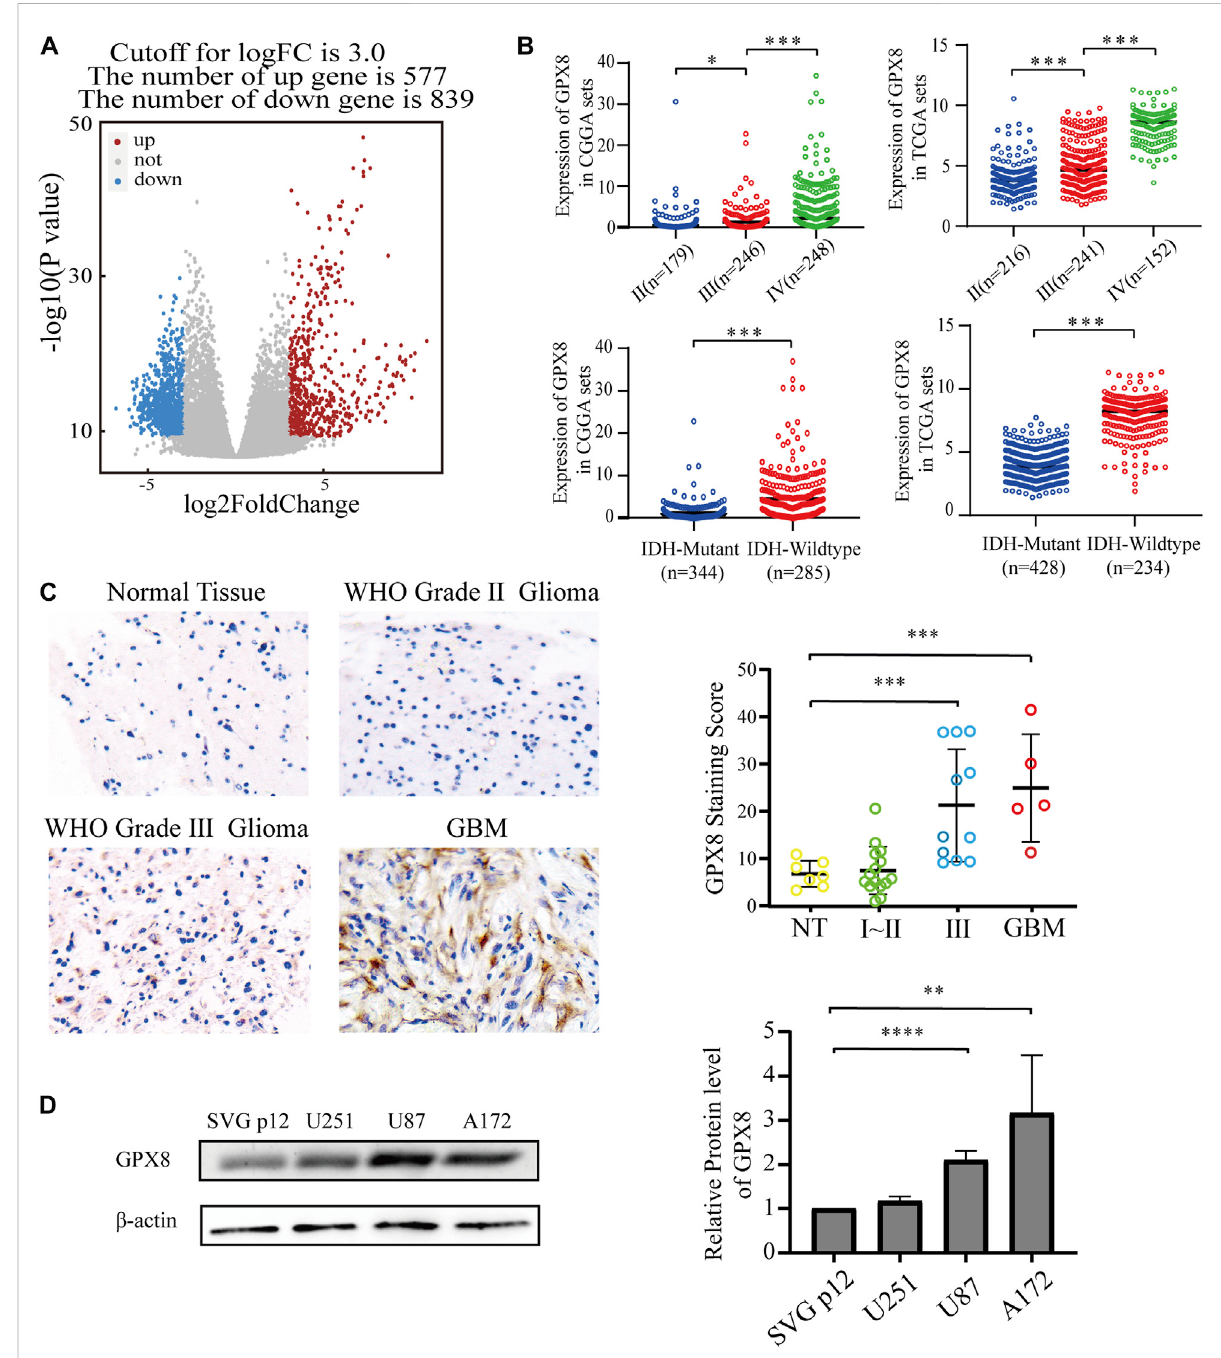
FIGURE 2 Expression of GPX8 was detected in gliomas. (A) Volcanic plot of DEGs of 166 GBM samples compared with fi ve normal tissue samples, the red plot speci fi es upregulated genes (n = 577), and the blue plot speci fi es downregulated genes (n = 839). (B) The mRNA expression of GPX8 in gliomas, upper panel according to WHO grade, and lower panel according to IDH status. (C,D) Protein expression of GPX8 in gliomas. * p < 0.05, ** p < 0.01, *** p < 0.001, and **** p <